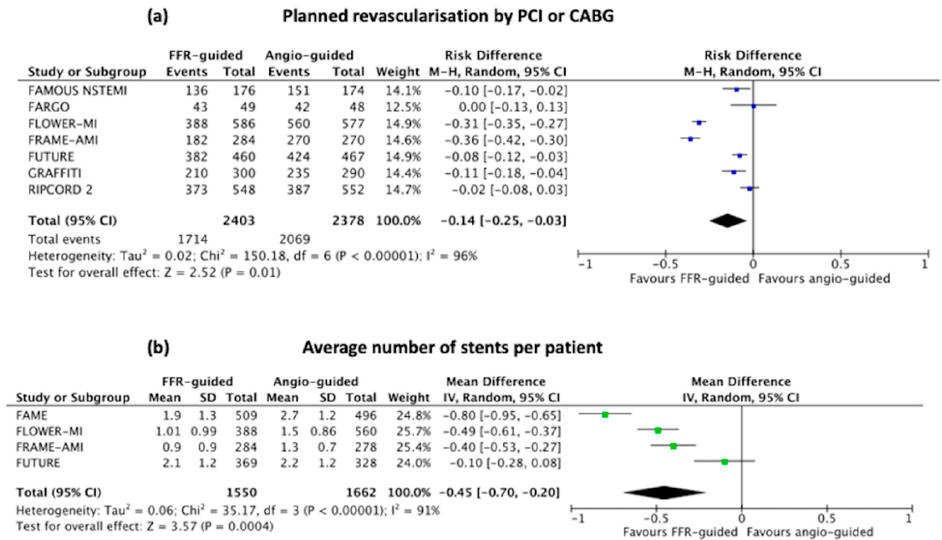
Figure 5. Forest plots of ( a ) average number of stented implanted; and ( b ) percentage of patients undergoing planned revascularisation as per their randomisation